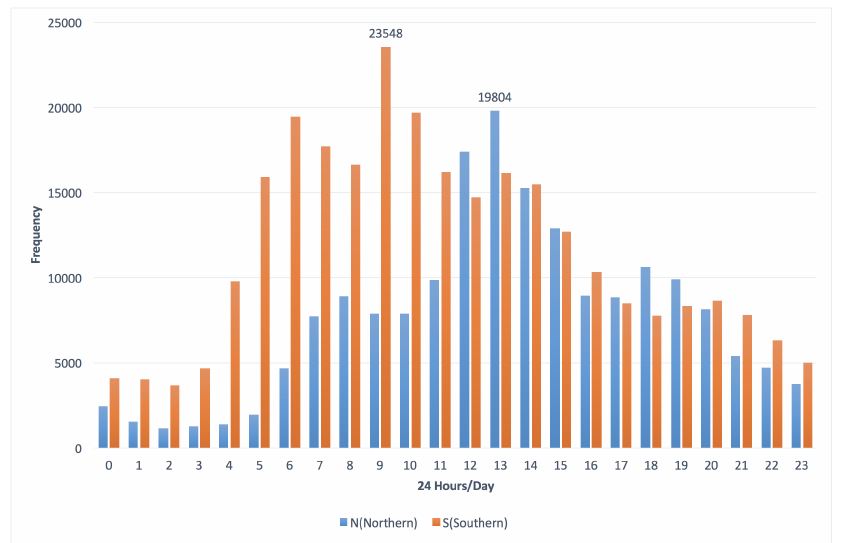
Figure 9. The frequency distribution of vehicles in the S (southern) and N (northern) directions according to “24 h per day”.